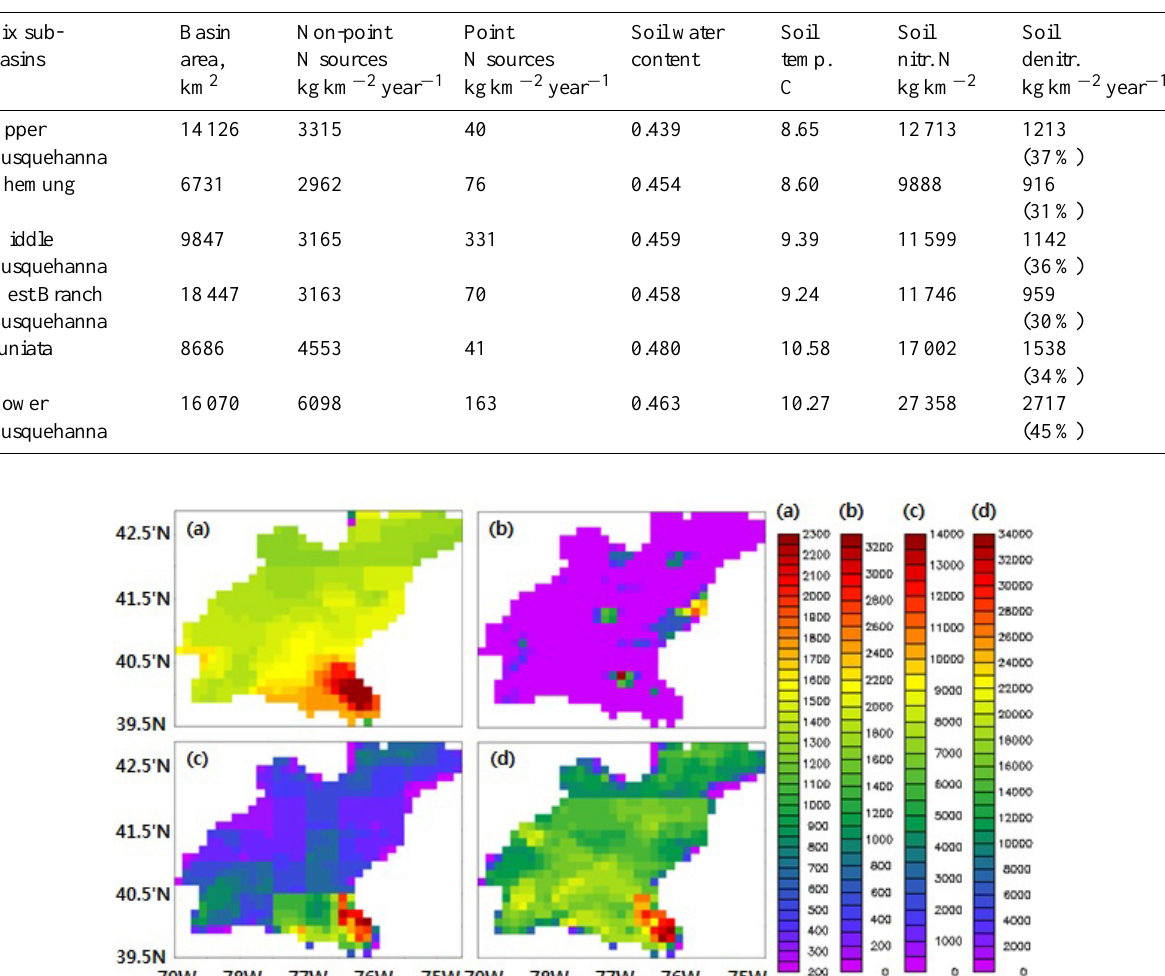
Table 4. Sub-basin area, 20year (1986–2005) average applied non-point and point N sources, and simulated soil water content, temperature, nitrate-N content, and denitrification rate (% of the non-point N sources) for each of six sub-basins.